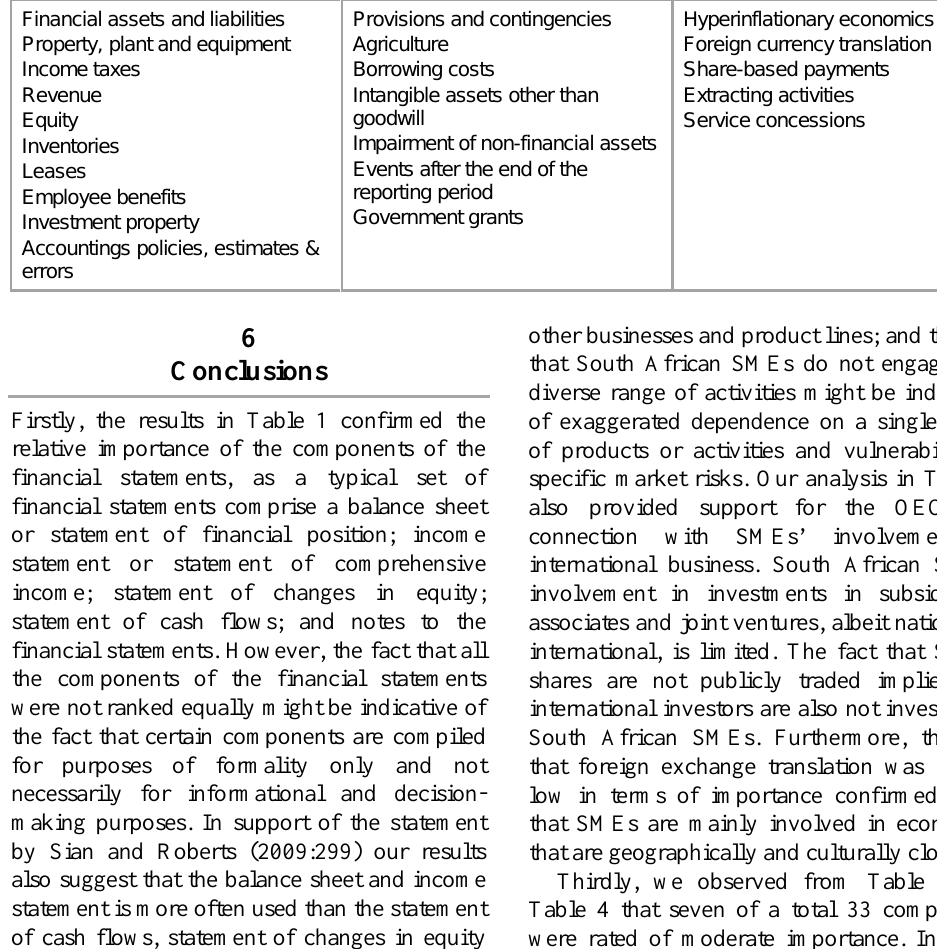
importance Moderately important Less important (2 (3 ranking)